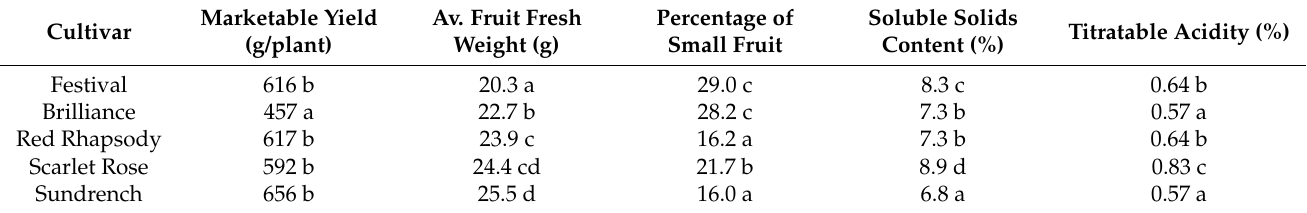
Table 4. Variations in total marketable yield, mean seasonal average fruit fresh weight (marketable), percentage of small fruit (<12 g fresh weight), fruit soluble solids content (SSC), and fruit titratable acidity (TA) in five strawberry cultivars in Queensland. Average seasonal fruit fresh weight is the long-term average value of fruit fresh weight in a cultivar pooled across all harvests (marketable fruit). Soluble solids content and titratable acidity were measured over seven harvests from 16 September to 28 July. Data are the means of six replicates per cultivar. Means in a column followed by a common letter are not significantly different by the Fisher’s least significant test at 5% level of significance.